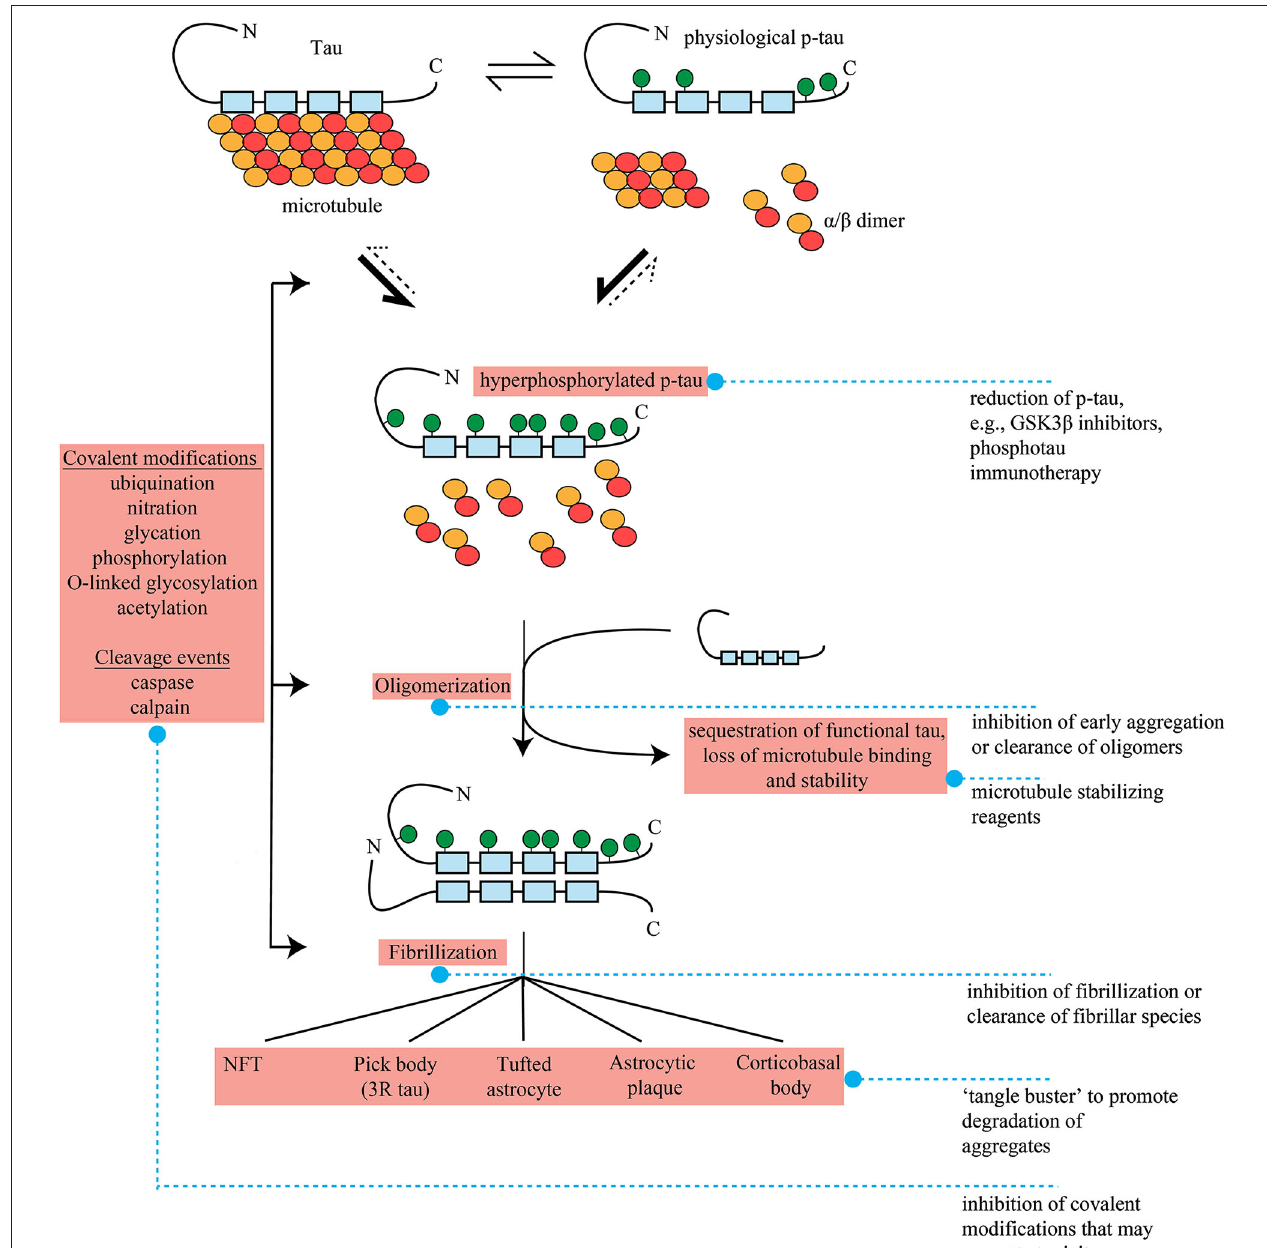
hyperphosphorylated tau into oligomers, and subsequently fibrils and aggregates. The repeat region of tau appears to form the core of these insoluble species. A number of other covalent modifications (ubiquination, nitration, glycation, phosphorylation, O-linked glycosylation) and cleavage events (caspase and calpain) may also occur at ill-defined junctures, and these may potentiate the dynamics of oligomerization or aggregate formation. As there are a range of pathological tau lesions which differ in appearance, these and other undefined pathways and potentially factors such as genetics, environmental inputs and cell type specific expression must differ in pathogenic tau formation. Pick bodies are entirely three repeat tau. Pathogenic species or potentially toxic mechanisms related to tau are highlighted in red. Blue dashed lines denote potential therapeutic interventions, see main text for more